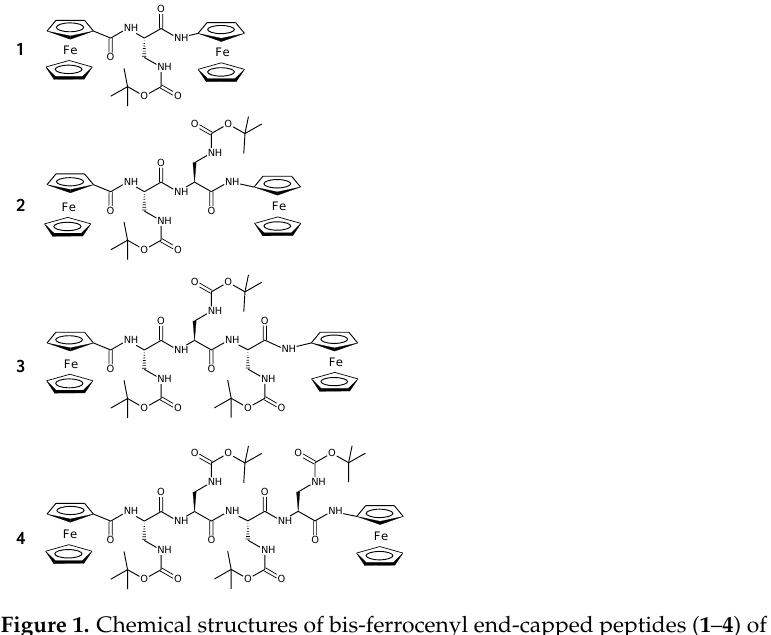
Figure 2. X-ray diffraction structure of 2 . H-atoms and the disordered, co-crystallized CDCl 3 mole- cule are omitted for clarity. Anisotropic displacement ellipsoids are drawn at the 30% probability level. The three intramolecular N – H … O=C H-bonds are indicated by dashed lines.